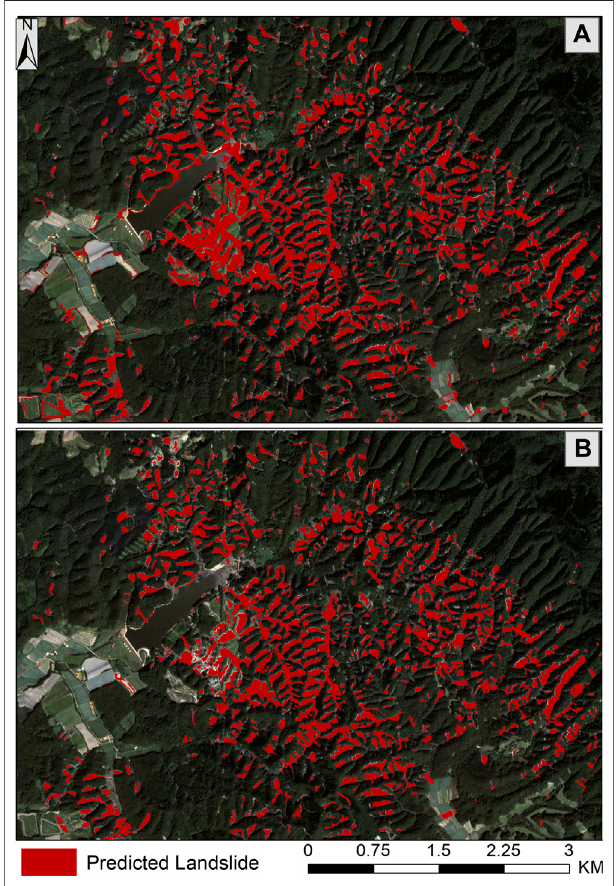
FIGURE 5 | Estimated landslides on the test area for model area 5 with RF classi fi er: (A) post-event dataset result, (B) change-based dataset result.